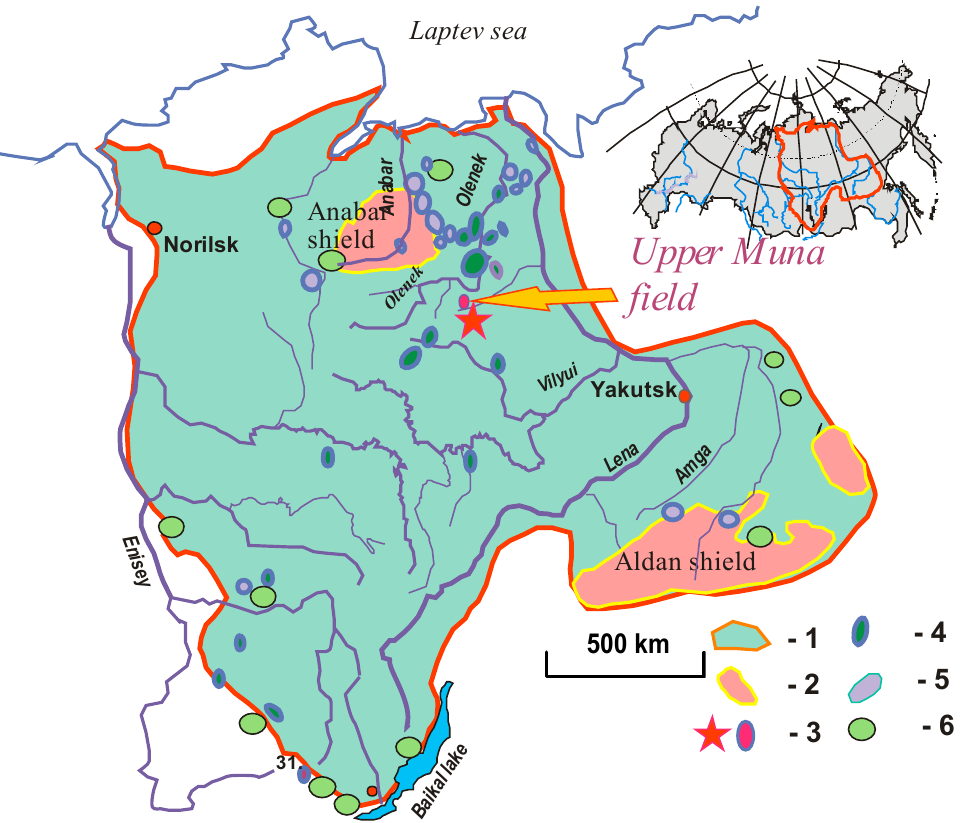
Figure 1. Location of the Upper Muna field and other kimberlite fields in Siberian platform 1. Siberian platform. 2. Shields. Kimberlite fields: 3. Upper Muna Field; 4. Late Devonian fields; 5. Lower Triassic and Jurassic fields [4,5]; 6. Carbonatite massifs.